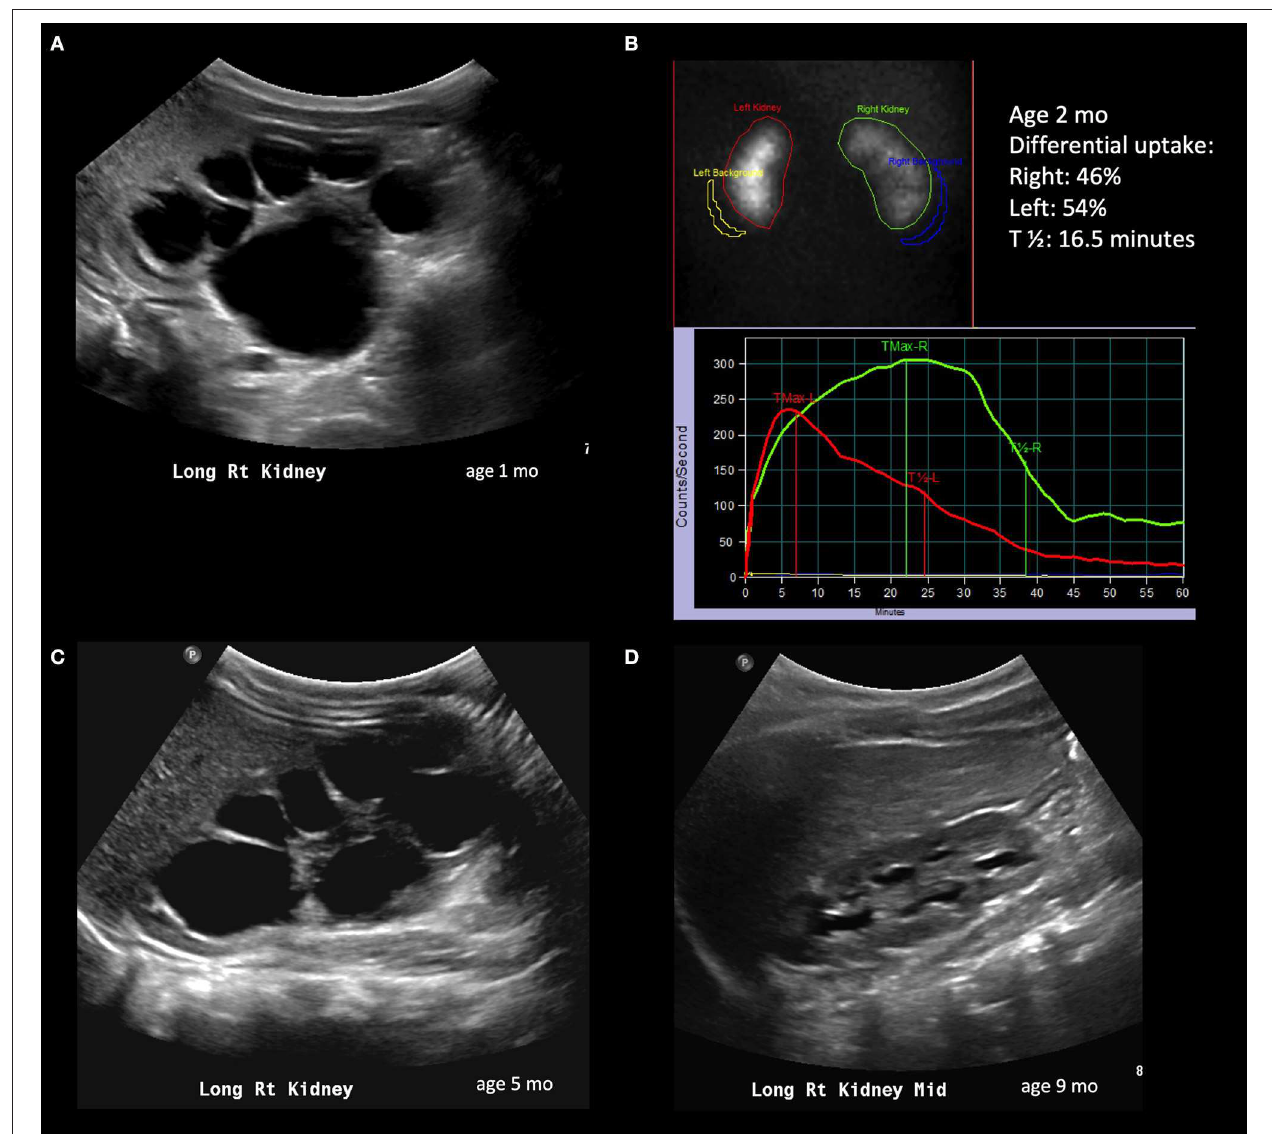
FIGURE 1 | Radiological history of an infant with resolution of severe hydronephrosis. (A) Postnatal ultrasound confirming prenatally diagnosed hydronephrosis; the image shows SFU grade 4 hydronephrosis with thinned isoechoic parenchyma. (B) Diuretic renogram performed at 2 months of age, showing symmetric uptake; despite the right kidney exhibits a delayed washout curve, it is still considered adequate. (C) Repeat ultrasound at 5 months showing persistent SFU grade 4 hydronephrosis. (D) Follow-up ultrasound at 9 months showing significant spontaneous improvement of hydronephrosis; the child will still however need follow-up imaging to ensure persistent